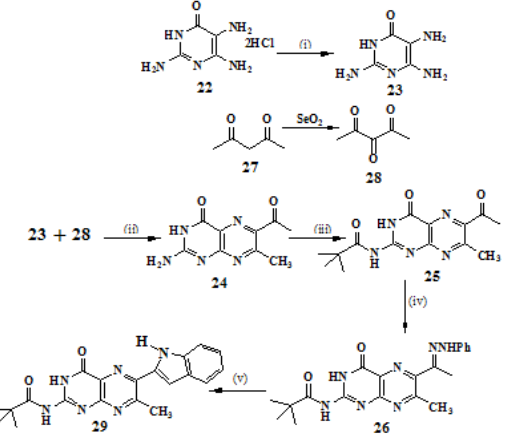
( b ) Figure 17: Molecular view of compounds (a) 31 and (b) 32 (adapted from ref. 57). The crystal packing of the major component for compounds (a) 31 and (b) 32 , viewed along the (a) b-axis and (b) a-axis. Photophysical properties of Compounds 29 and 33: We have examined the fluorescence behaviour of 29 (indolopterin) and 33 (indolo quinoxaline) in several solvents. In non-polar aprotic solvents (e.g hexane, CCl 4 and